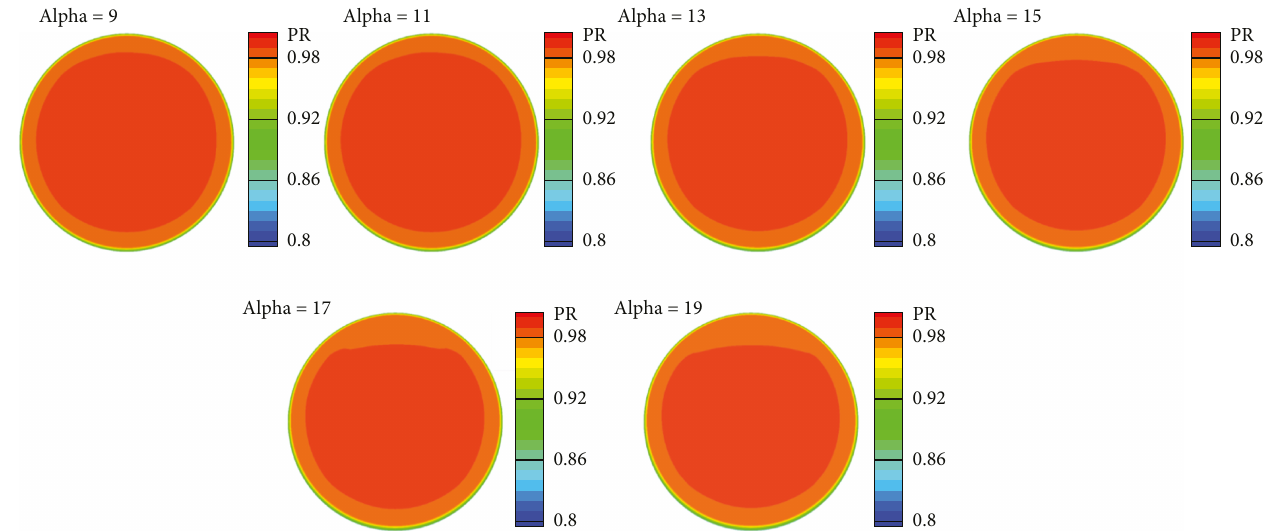
Figure 27: The inlet distortion of the engine alone at di ff erent attack angles (low